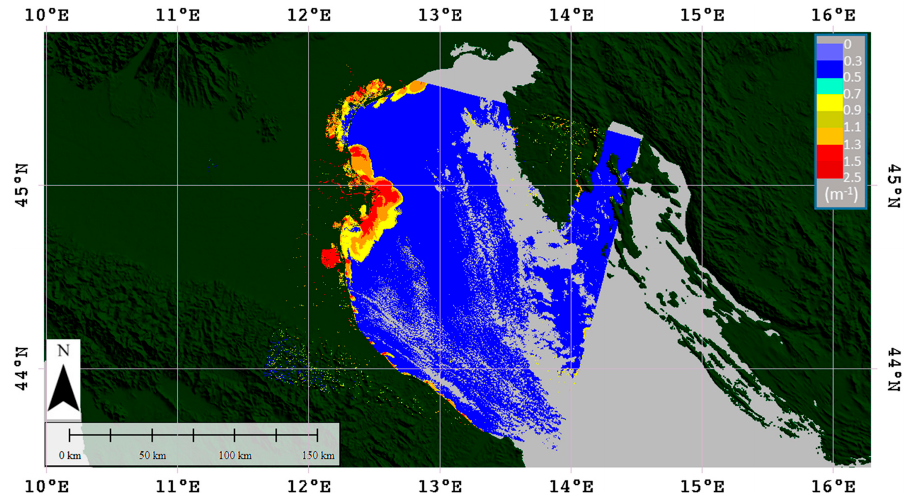
Figure 11. CDOM (m − 1 ) map retrieved by applying Model 2 equation to the Landsat 8 R rs acquired on the NCWAS on 19 November 2016. CDOM map is overlaid (only for visualization purposes) on ASTER GDEM World Wide Elelvation data (1 arc-second of spatial resolution) where dark green colour depicts land and the light grey colour the sea (in our case no-data values due to the clouds).